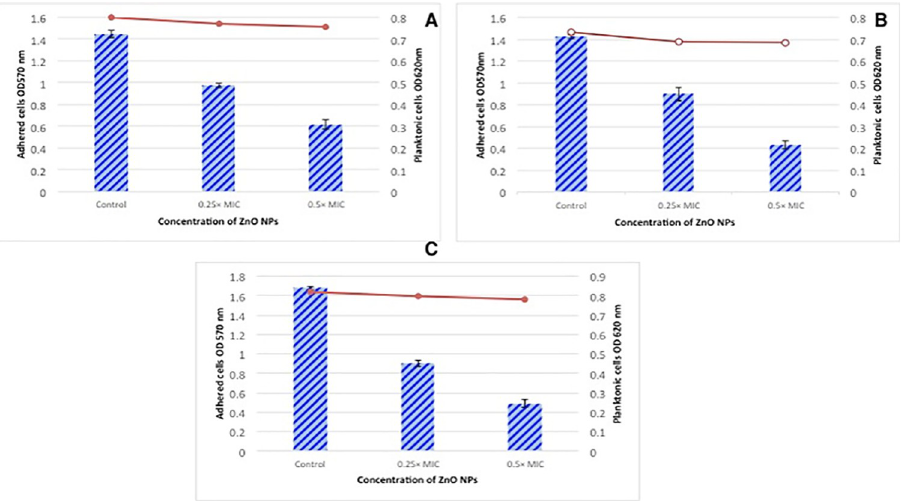
Fig 6. Antibiofilm activities of green synthesized ZnO NPs against multidrug-resistant foodborne pathogens (A) S . aureus , (B) S . enterica , (C) E . coli